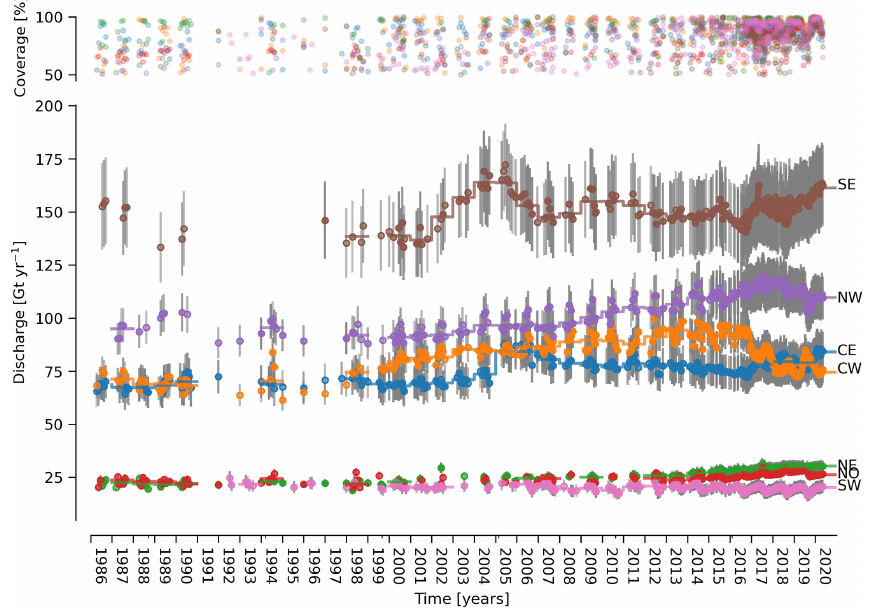
Figure 5. Bottom panel: time series of ice discharge by region. Same graphical properties as Fig.